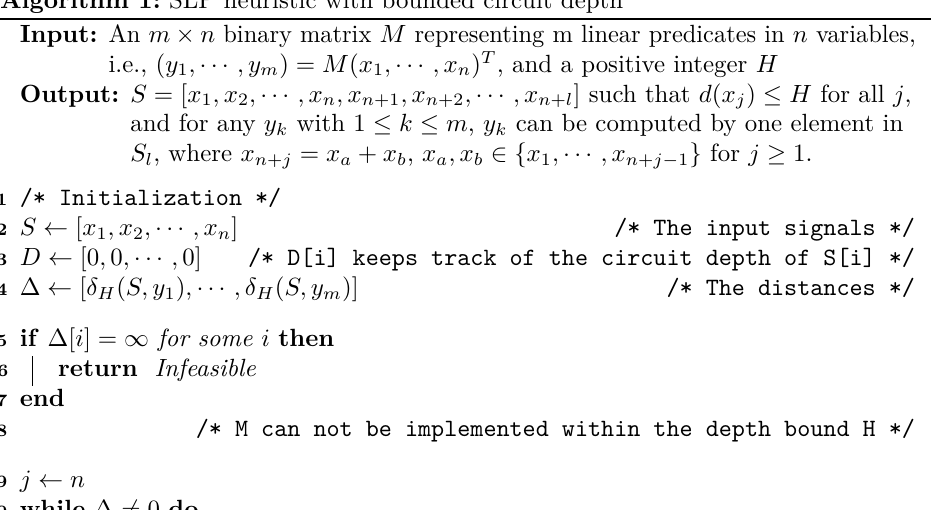
Algorithm 1: SLP heuristic with bounded circuit